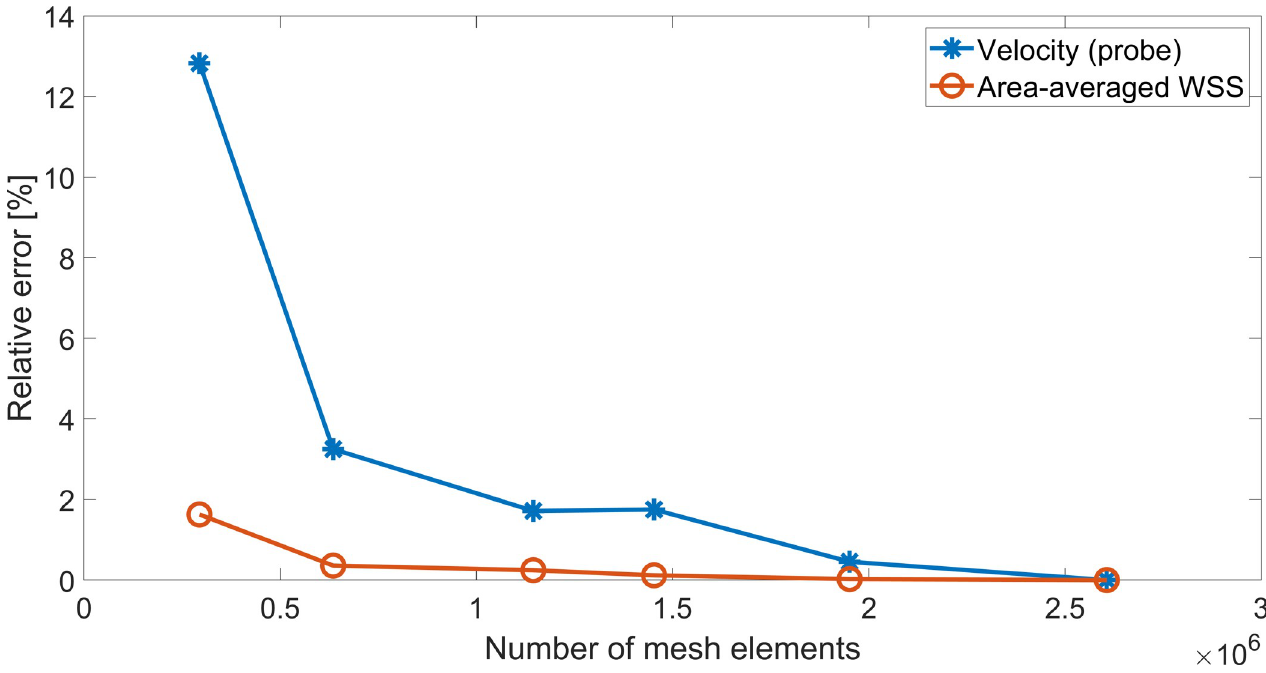
Fig 6. Mesh convergence study for RA model.